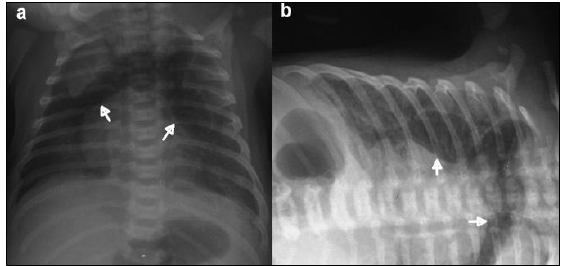
Figure 1: Chest X-ray films: (a) supine position (b) cross- table lateral view. Chest X-ray films demonstrate multi- loculated large quantity of air in the mediastinum (white arrows), causing elevation of the thymus. There is no dis- placement of the multiseptated- multiloculated air on